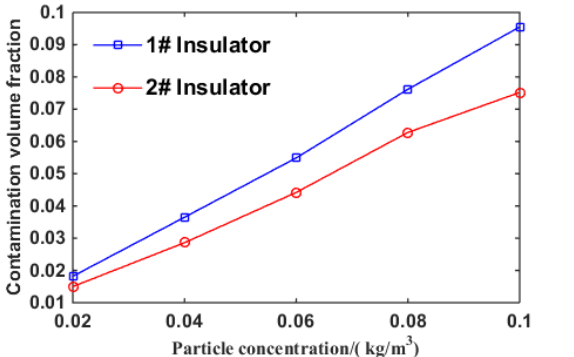
Figure 19. Variation of contamination of volume fraction with particle